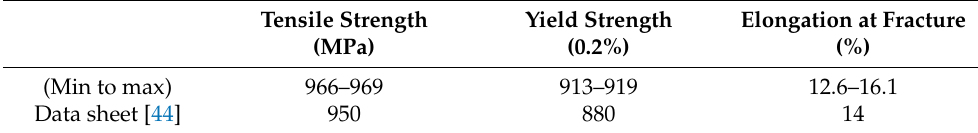
Table 3. Tensile properties of Ti-6Al-4V workpiece.